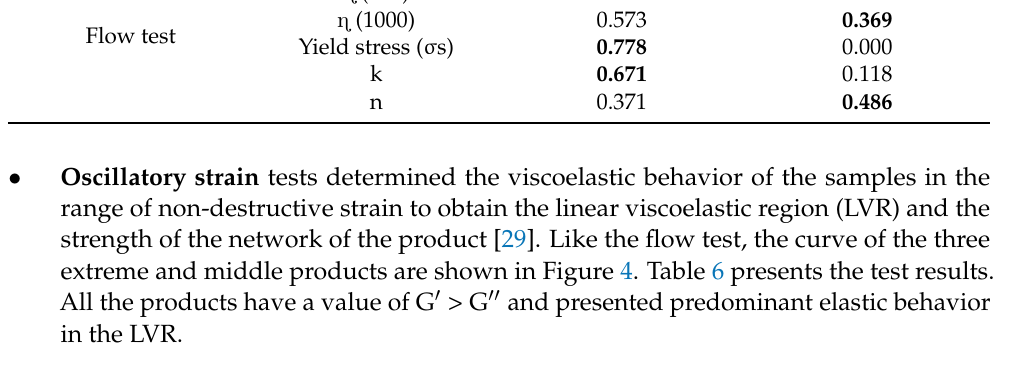
Table 6. Rheological data (means ± SD) obtained from the strain tests for the 13 emulsions. The value of G (cid:48) , G (cid:48)(cid:48) and tan δ correspond to the linear viscoelastic region